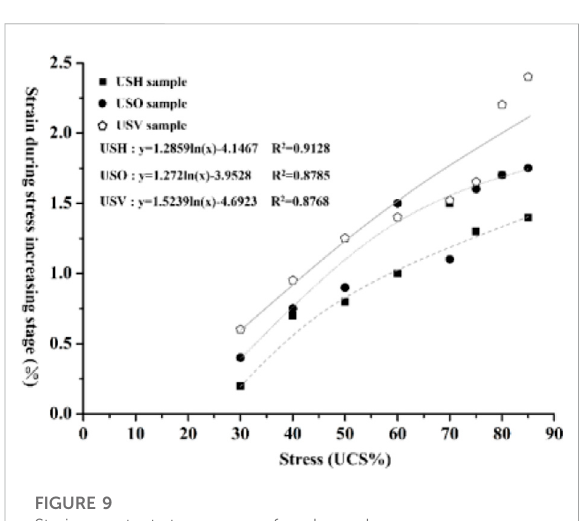
FIGURE 9 Strain-constant stress curve of coal samples.